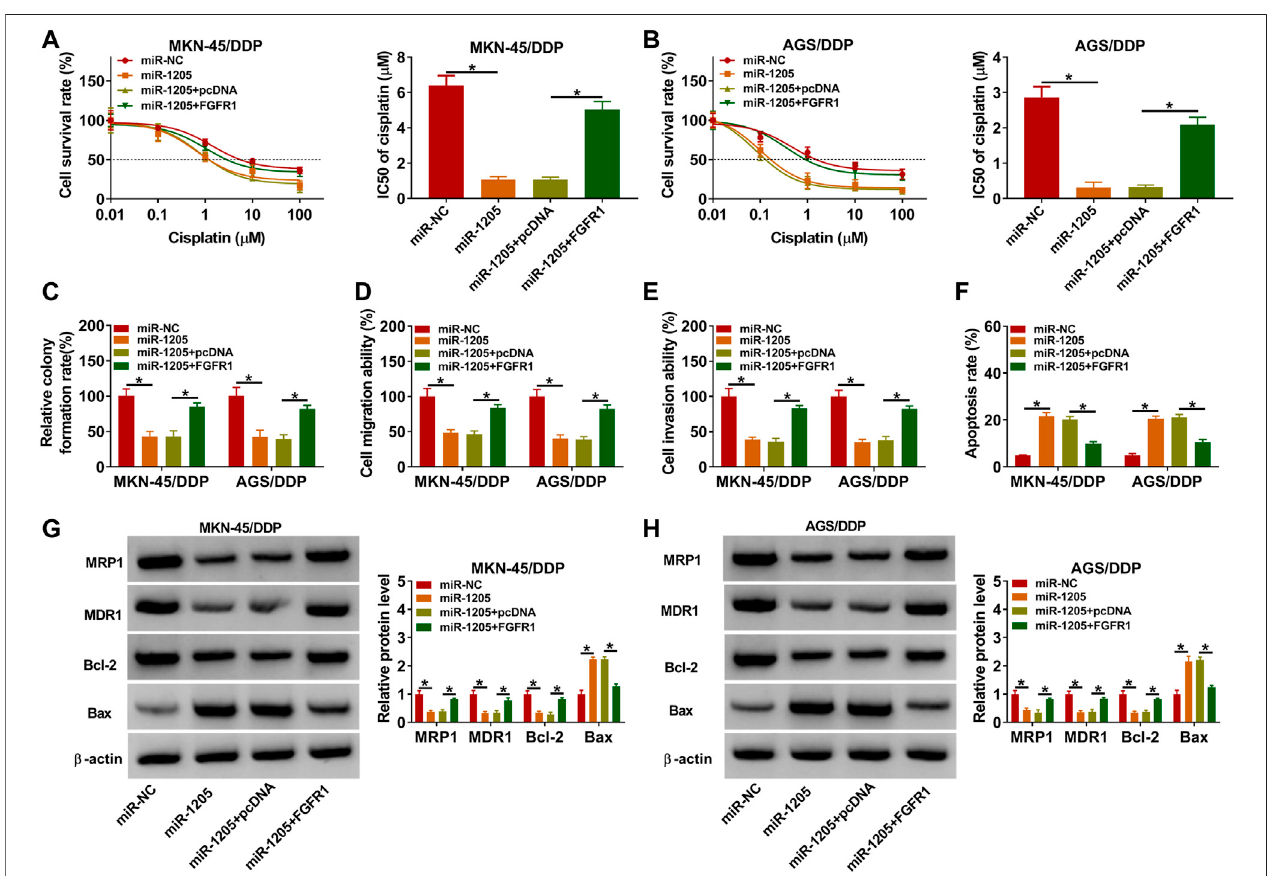
FIGURE 6 | MiR-1205 regulated the DDP resistance and malignant behaviors of DDP-resistant GC cells by targeting FGFR1. MKN-45/DDP and AGS/DDP cells weretransfectedwithmiR-NC,miR-1205,miR-1205+pcDNAormiR-1205+FGFR1. (A,B) DDPresistancewasanalyzedbyCCK-8assay. (C – F) Thecolonyformation, migration, invasion and apoptosis of MKN-45/DDP and AGS/DDP cells were evaluated by colony formation assay, transwell assay and fl ow cytometry analysis, respectively. (G,H) The protein levels of MRP1, MDR1, Bcl-2 and Bax in MKN-45/DDP and AGS/DDP cells were measured via western blot assay. * p <